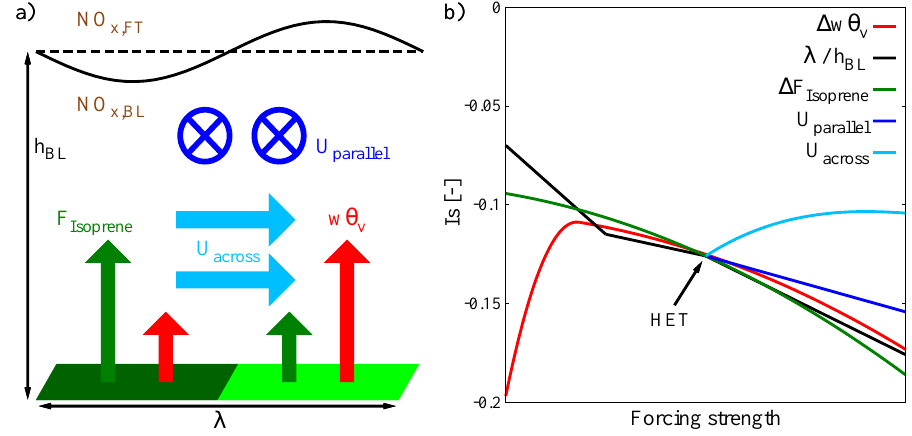
Fig. 15. Governing variables which affect the segregation of chemical species (a) and the resulting intensity of segregation for Reaction (R9) as a function of the magnitude of those variables (see descriptions of sensitivity analysis experiments in Table 3 and their results in Table 4) (b) . The governing variables are the surface buoyancy flux difference , the length scale of heterogeneity , the isoprene emission difference , wind blowing parallel to the borders between forest and grass and wind blowing across those borders. The control numerical experiment with heterogeneous surface forcing, HET, is indicated with an arrow. Not shown in panel (b) is the impact of NO x mixing ratios and their distribution within the boundary layer and free troposphere on the intensity of segregation for Reaction (R9).